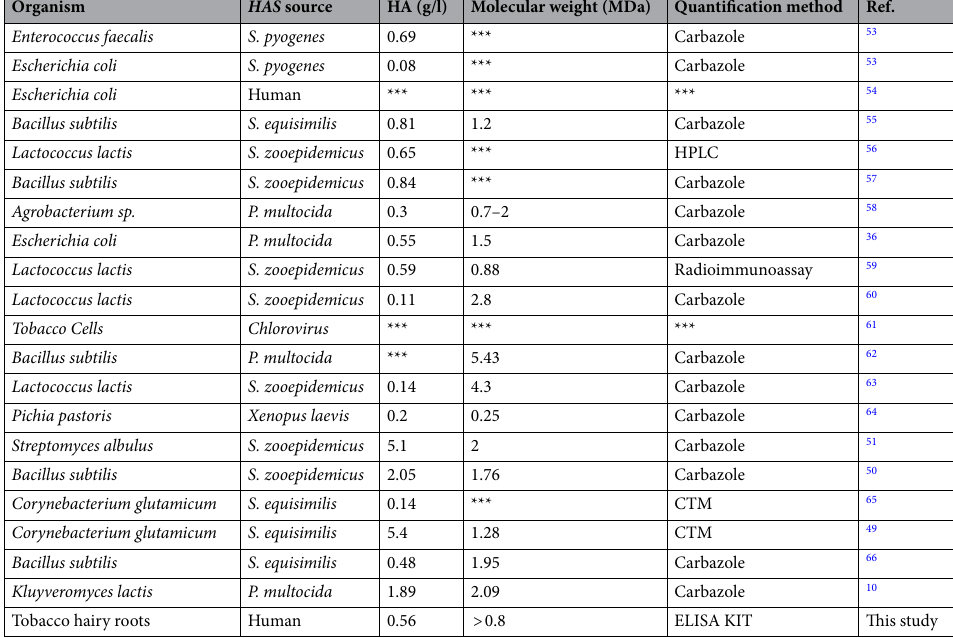
Figure 5. Comparison of hHAS2 and HA concentrations in transgenic hairy roots and the same regenerated shoots. (A) Comparison of hHAS2 concentration in hairy roots and regenerated shoots measured by hHAS2 ELISA kit. (B) Comparison of HA concentration in hairy roots and regenerated shoots measured by HA ELISA kit. The Student’s t-test was used for the hHAS2 and HA data. The values are expressed as mean ± standard error (SE) (***p < 0.001).